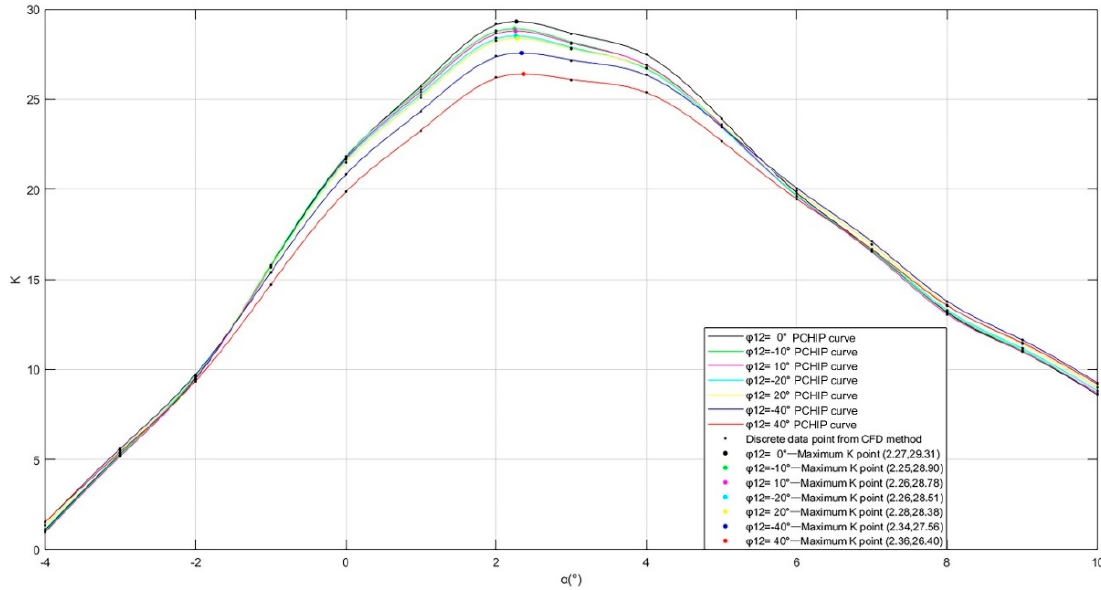
Figure 10. Lift–drag ratio distribution with different relative roll angles.